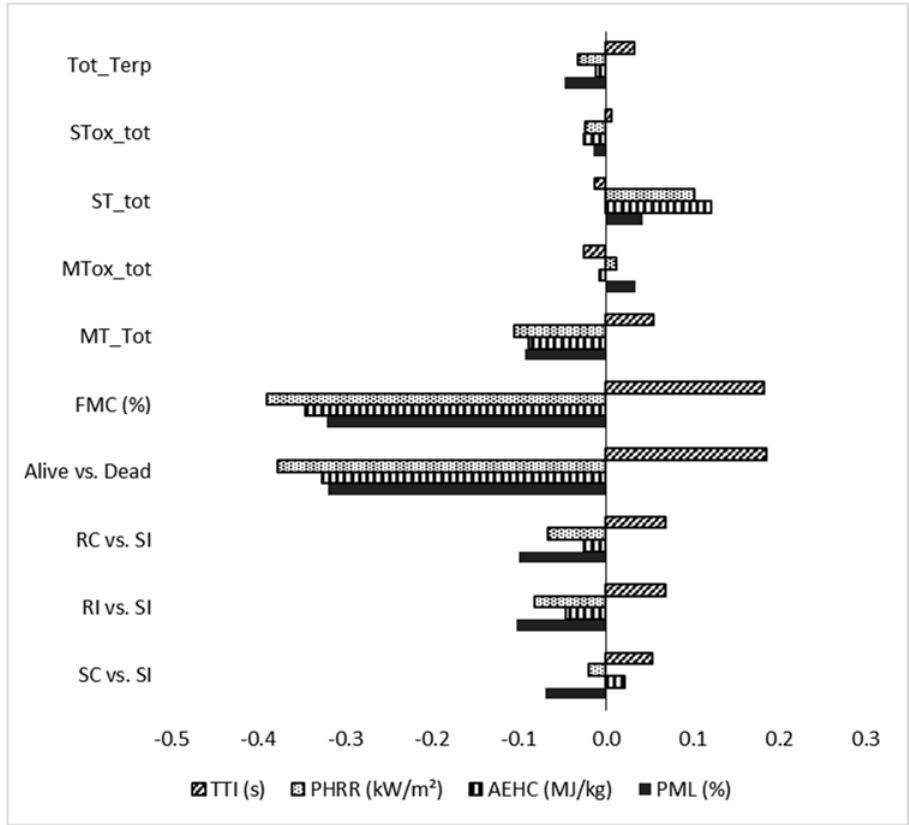
Figure 2. Scaled coefficients for the predictive variables of the flammability parameters: TTI (ignitability), PHRR (combustibility), AEHC (sustainability) and PML (consumability). The scaled coefficients show the relative importance of each variable in the structure of the PLS model (N = 36).